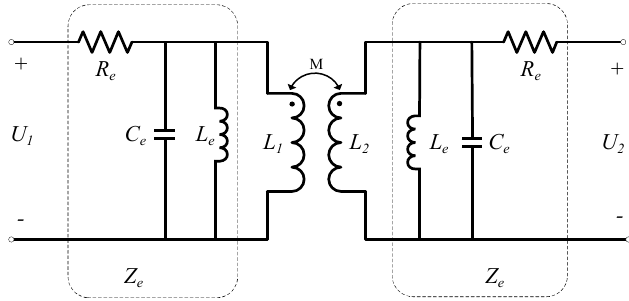
Figure 2. Equivalent circuit model for transport in a seawater environment.